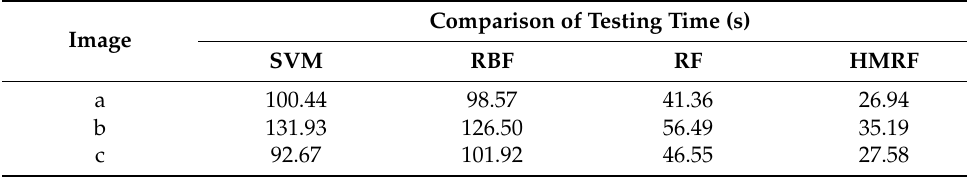
Table 6. Comparison of testing time of different classification algorithms with the road